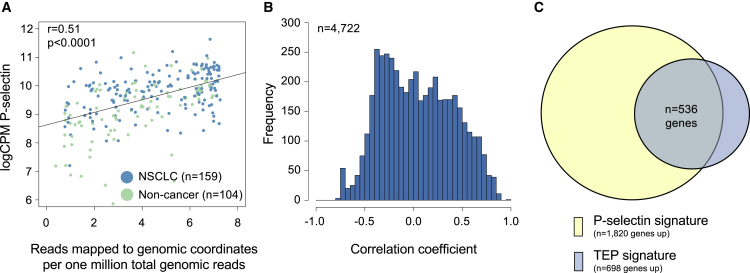
P-Selectin Signature(A) Correlation plot (Pearson's correlation) of proportion of reads mapping to exonic coordinates (x axis) versus the log2-transformed, RUV-corrected, and counts-per-million (logCPM) of P-selectin. Each dot represents a sample, colored by clinical group.(B) Distribution of Pearson's correlation coefficients of the correlation between logCPM levels of 4,722 genes and the logCPM of P-selectin. A subset of the genes show a strong positive correlation with P-selectin (r approximates 1), whereas others do not (r approximates 0).(C) Venn diagram overlay of genes upregulated in the NSCLC TEP signature and genes with a significant positive Pearson's correlation (FDR < 0.01) toward P-selectin. Number of overlapping genes is indicated in the Venn diagram.